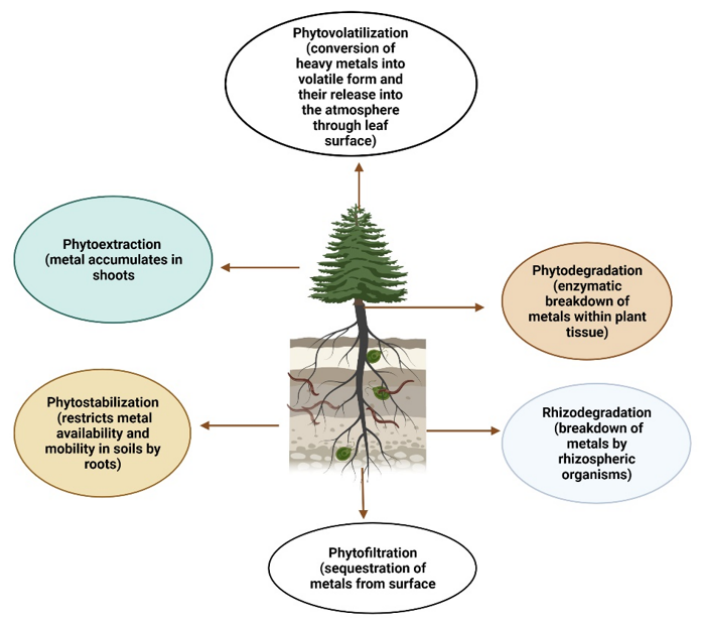
Figure 2. Techniques of phytoremediation and the destinies of pollutants.